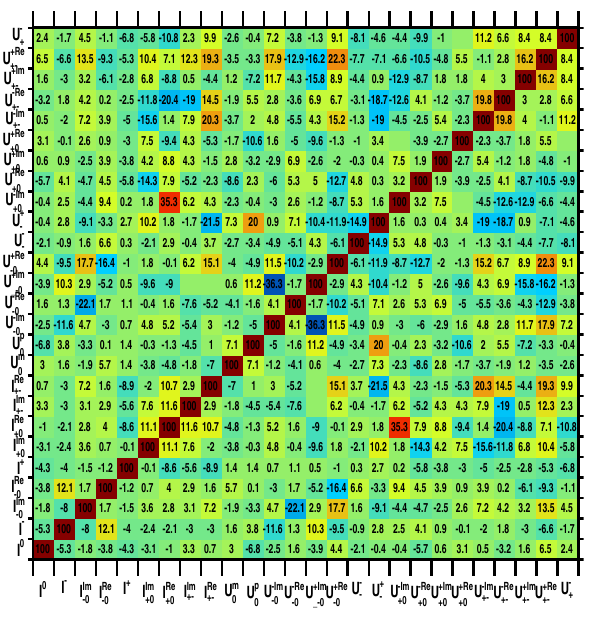
Table 7 Correlation matrix of correlations, in percent, for the U and I coefficients extracted from the time-dependent Dalitz analysis of the B 0 → (ρπ) 0 decay [48,49]